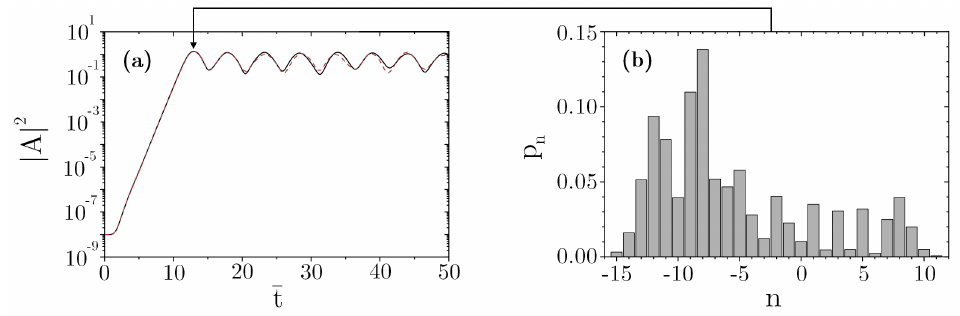
Figure 7. ( a ): | A | 2 vs. ¯ t and ( b ) p n = | c n | 2 vs. n for ¯ κ = 0, ρ = 10 and ¯ δ = 1/2 ρ